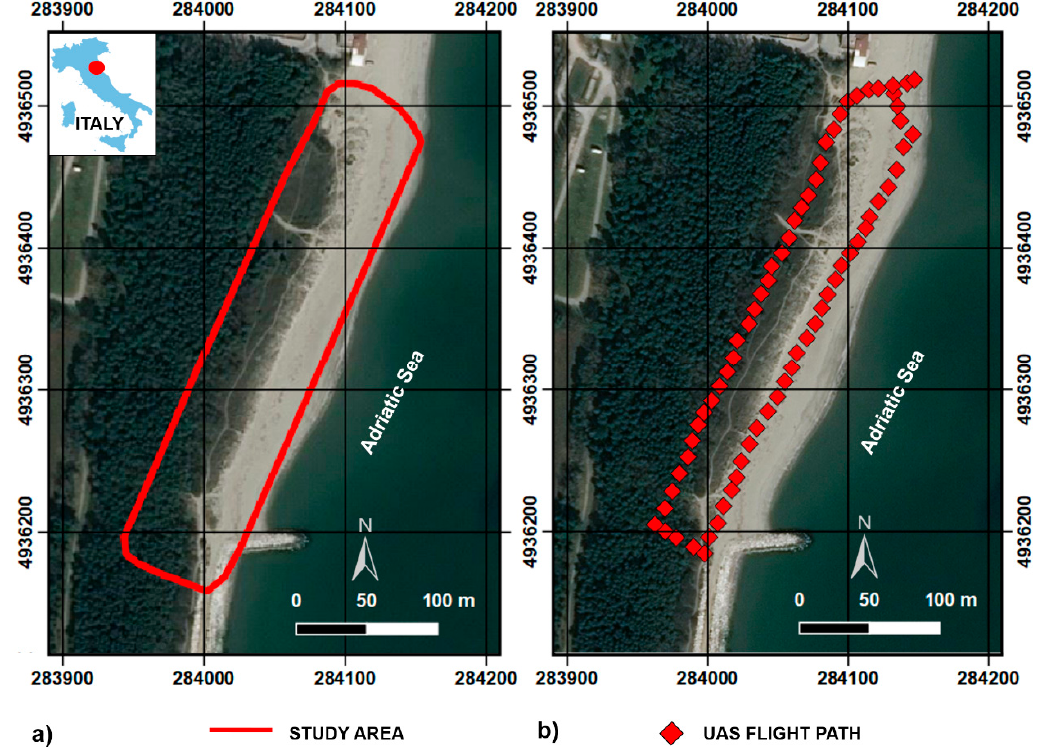
Figure 1. ( a ) Study area: Casal Borsetti dune, Ravenna, Italy. ( b ) Unmanned aerial vehicle flight path. Figure 1. (a) Study area: Casal Borsetti dune, Ravenna, Italy. (b) Unmanned aerial vehicle flight path. The red squares correspond to the centers of acquisition (WGS84 / UTM zone 33N) (Image background: The red squares correspond to the centers of acquisition (WGS84/ UTM zone 33N) (Image Google background: Google Earth).